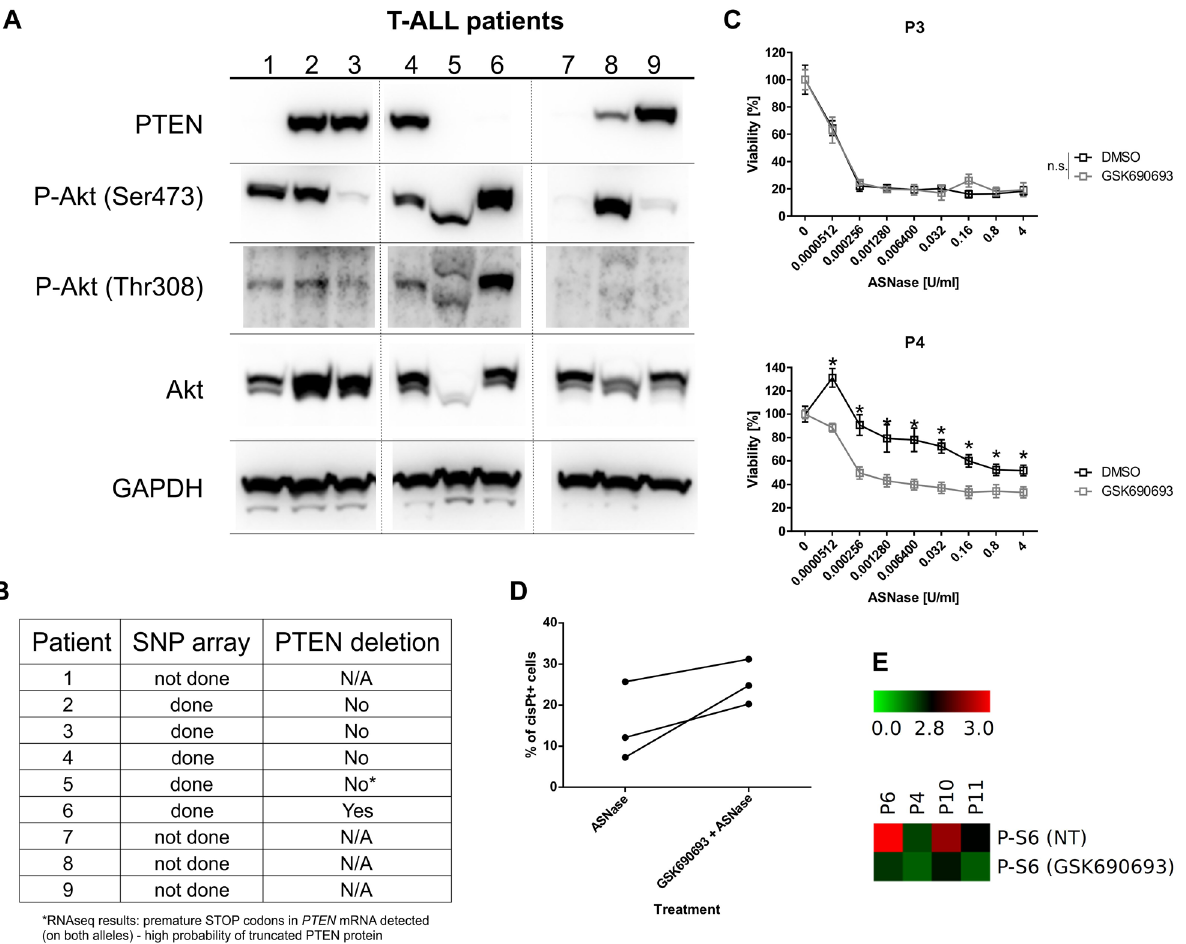
Figure 5. Characterization of primary leukemia cells from pediatric T-ALL patients. ( A ) The immunoblot analysis of PTEN, P-Akt and Akt in primary leukemia cells. GAPDH is shown as a loading control. Different gels are separated by lines. ( B ) SNP array analysis results from T-ALL primary cells regarding the PTEN deletion. ( C ) The effect of the Akt inhibitor (1 µM GSK690693) on the sensitivity of primary T-ALL cells to ASNase based on MTS assays. ( D ) The effect of the Akt inhibitor (1 µM GSK690693) on the sensitivity of primary T-ALL cells to ASNase based on CisPt + cells detected on mass cytometry. Cells were treated for 5 h with 1 µM GSK690693 only or in combination with 0.1 U/mL of ASNase. ( E ) Phosphorylation of S6 in cells from T-ALL patients. Untreated (NT) or treated with 1 µM GSK690693 for 6 h. * = FDR < 0.1%, n.s. not